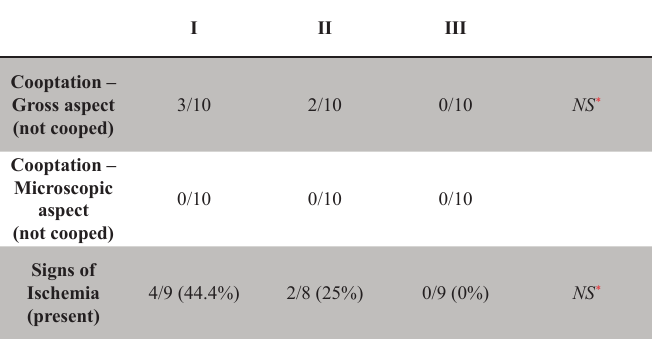
TABLE 2 - Morphological aspects of